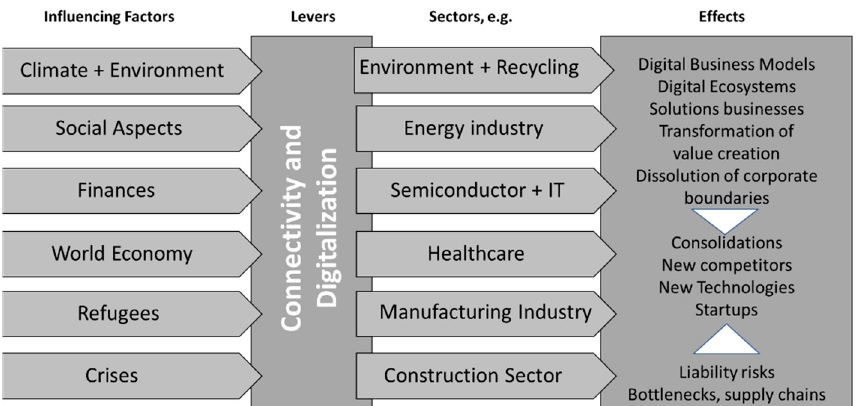
Figure 1. The world in transformation mode.